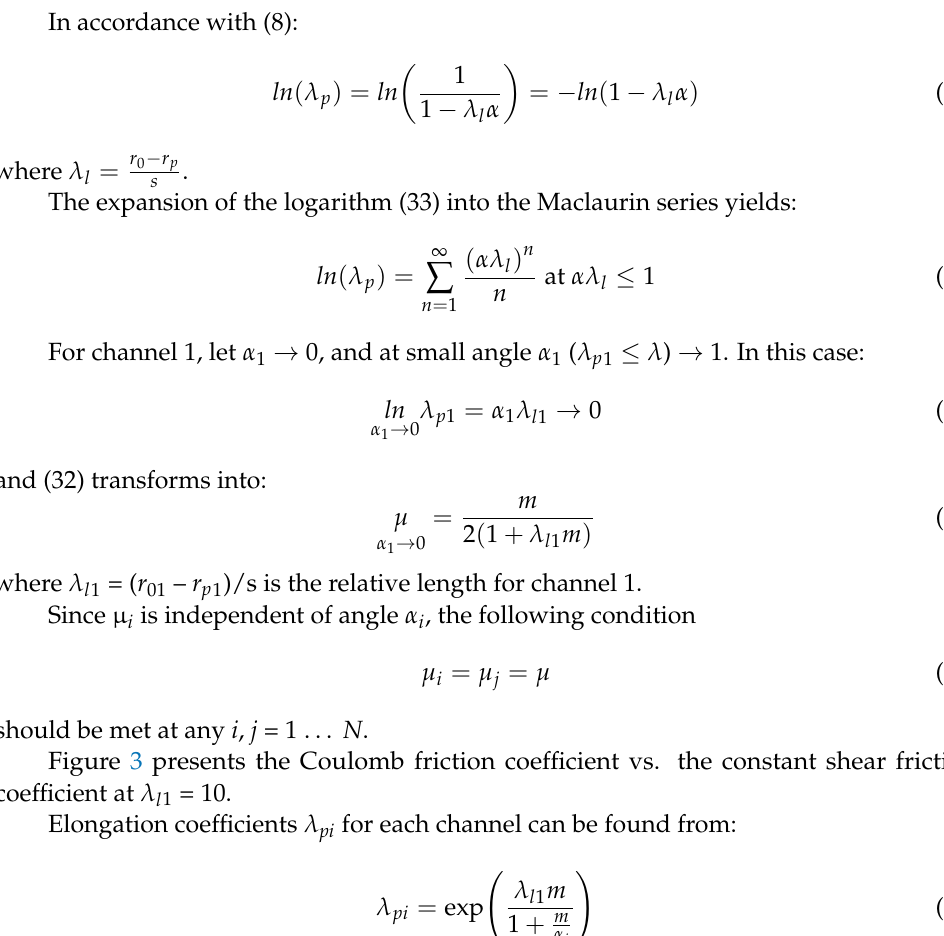
Figure 2. Upper boundary of C as a function of the elongation coefficient. The channel numbers associated with the index are denoted as i = 1 . . . N